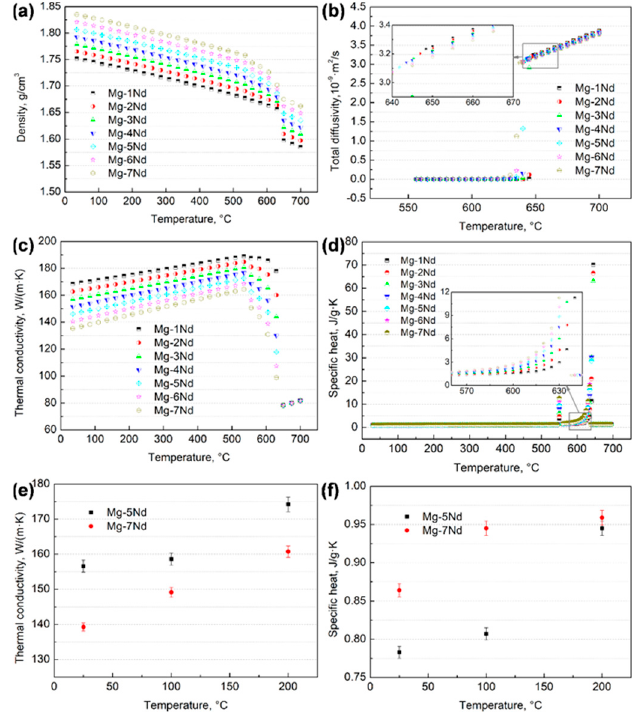
Figure 2. Thermophysical parameters of Mg–Nd system alloys: ( a ) density; ( b ) total diffusivity; ( c ) and ( e ) thermal conductivity, obtained by calculation and experiment; ( d ) and ( f ) specific heat, obtained by calculation and experiment. Table 2. Thermophysical parameters of Mg–Nd alloy from Refs [31,36–38].